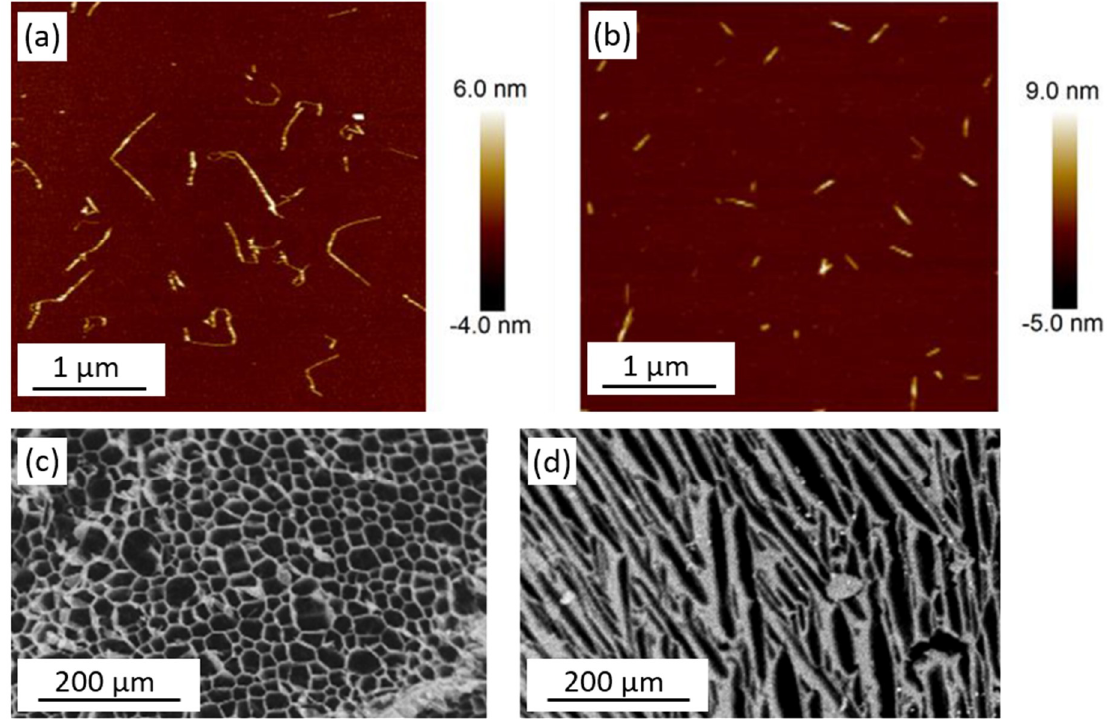
Figure 16. AFM images of CNFs ( a ) and CNCs ( b ). The nanocellulose particles are electrostatically adsorbed onto cationised mica substrates. The magnification is the same in both images and the scale bar is 500 nm. SEM micrographs of CNF ( c ) and ( d ) CNC foams obtained by ice‐templating from a 0.5 wt% CNF suspension and a 1.5 wt% CNC suspension, respectively. (Adapted with permission from Munier et al. [120]. Copyright 2016 American Chemical